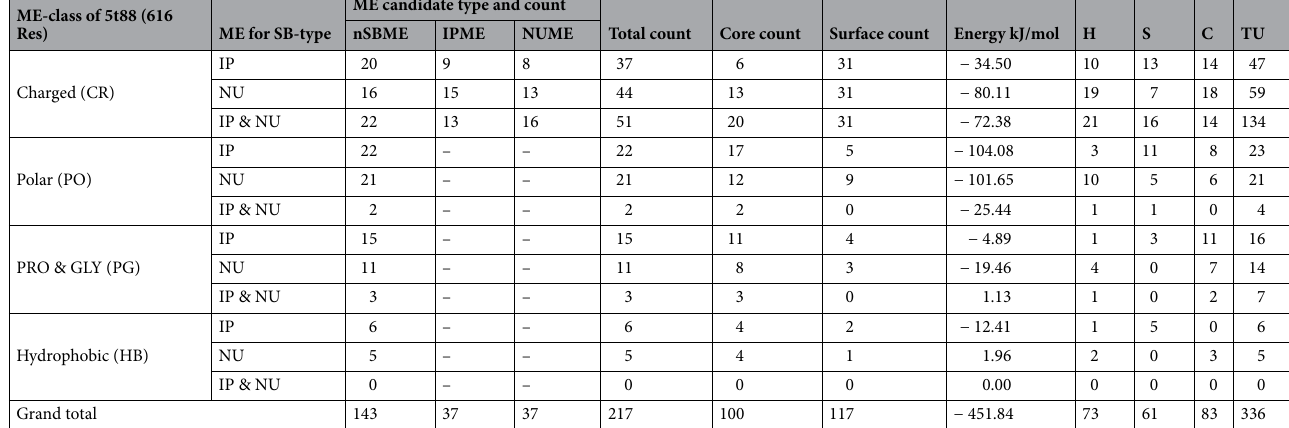
Table 2. Classes, categories, binary details, and interaction energies of microenvironment residues of 5t88. The energy cut-off was ± 0.75 kJ/mol. ME-energy of IP (isolated pair) and NU (network pair) salt-bridge was extracted using IPM and NUM method, respectively. H ME count in helix, S ME count in strand, C ME count in coil, TU times used.